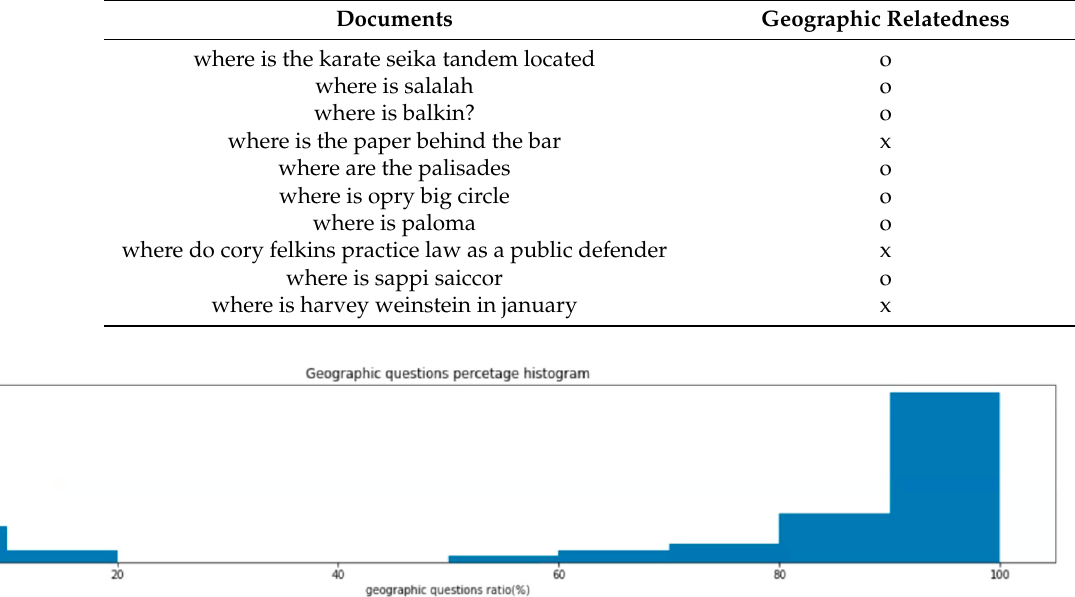
Figure 6. Histogram of geographic question ratio. The X-axis represents the geographic questions ratio ranging from 0% to 100% (by step size of 10%). The Y-axis represents the number of topics (counts) with specific geographic questions ratio. Over 25 topics possess 100% geographic related- ness.